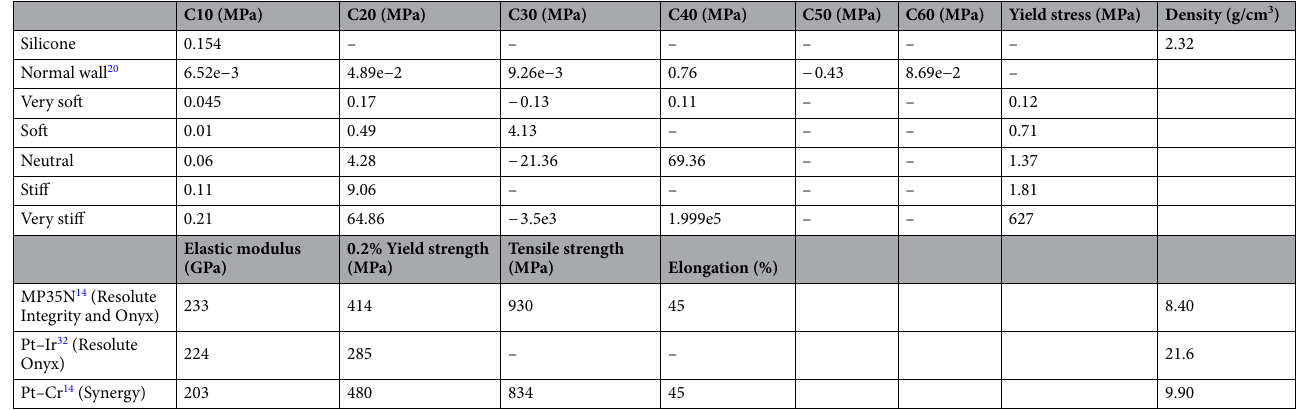
Table 2. Coefficients for the material models used in computational stenting simulations of bench and clinical